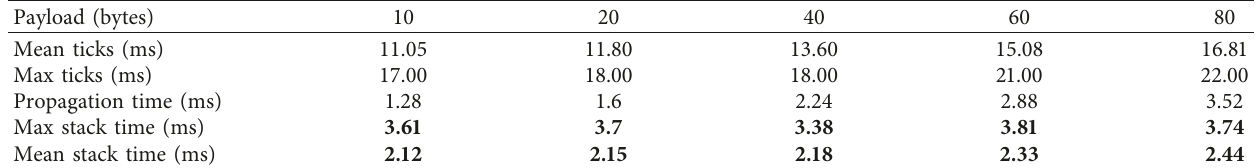
Table 1: Communication test results in function of payload.